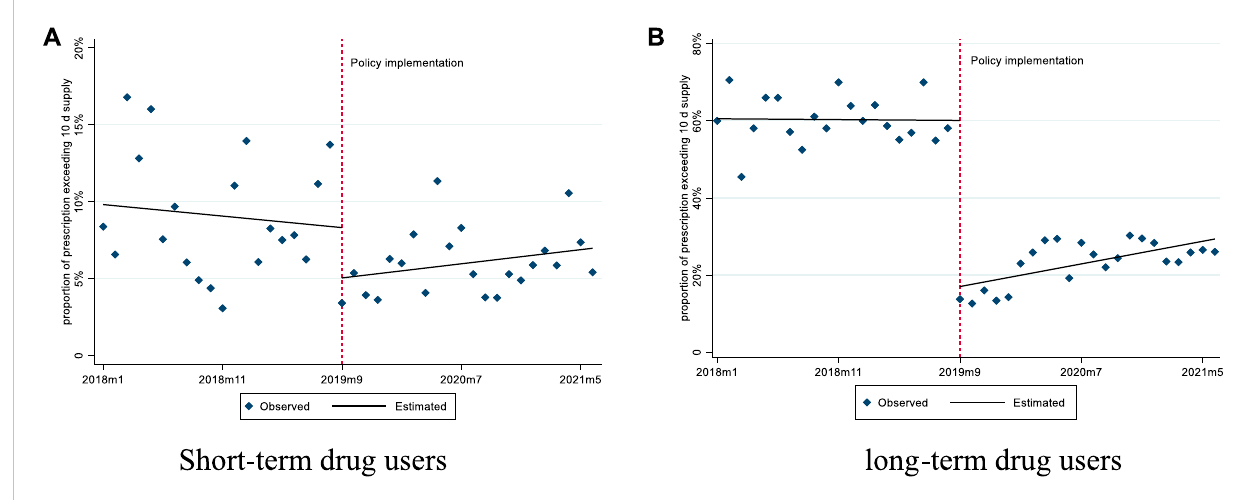
FIGURE 4 Changes in the proportion of prescription exceeding 10 days ’ supply for short-term and long-term drug users. (A) Short-term drug users (B) long- term drug users.